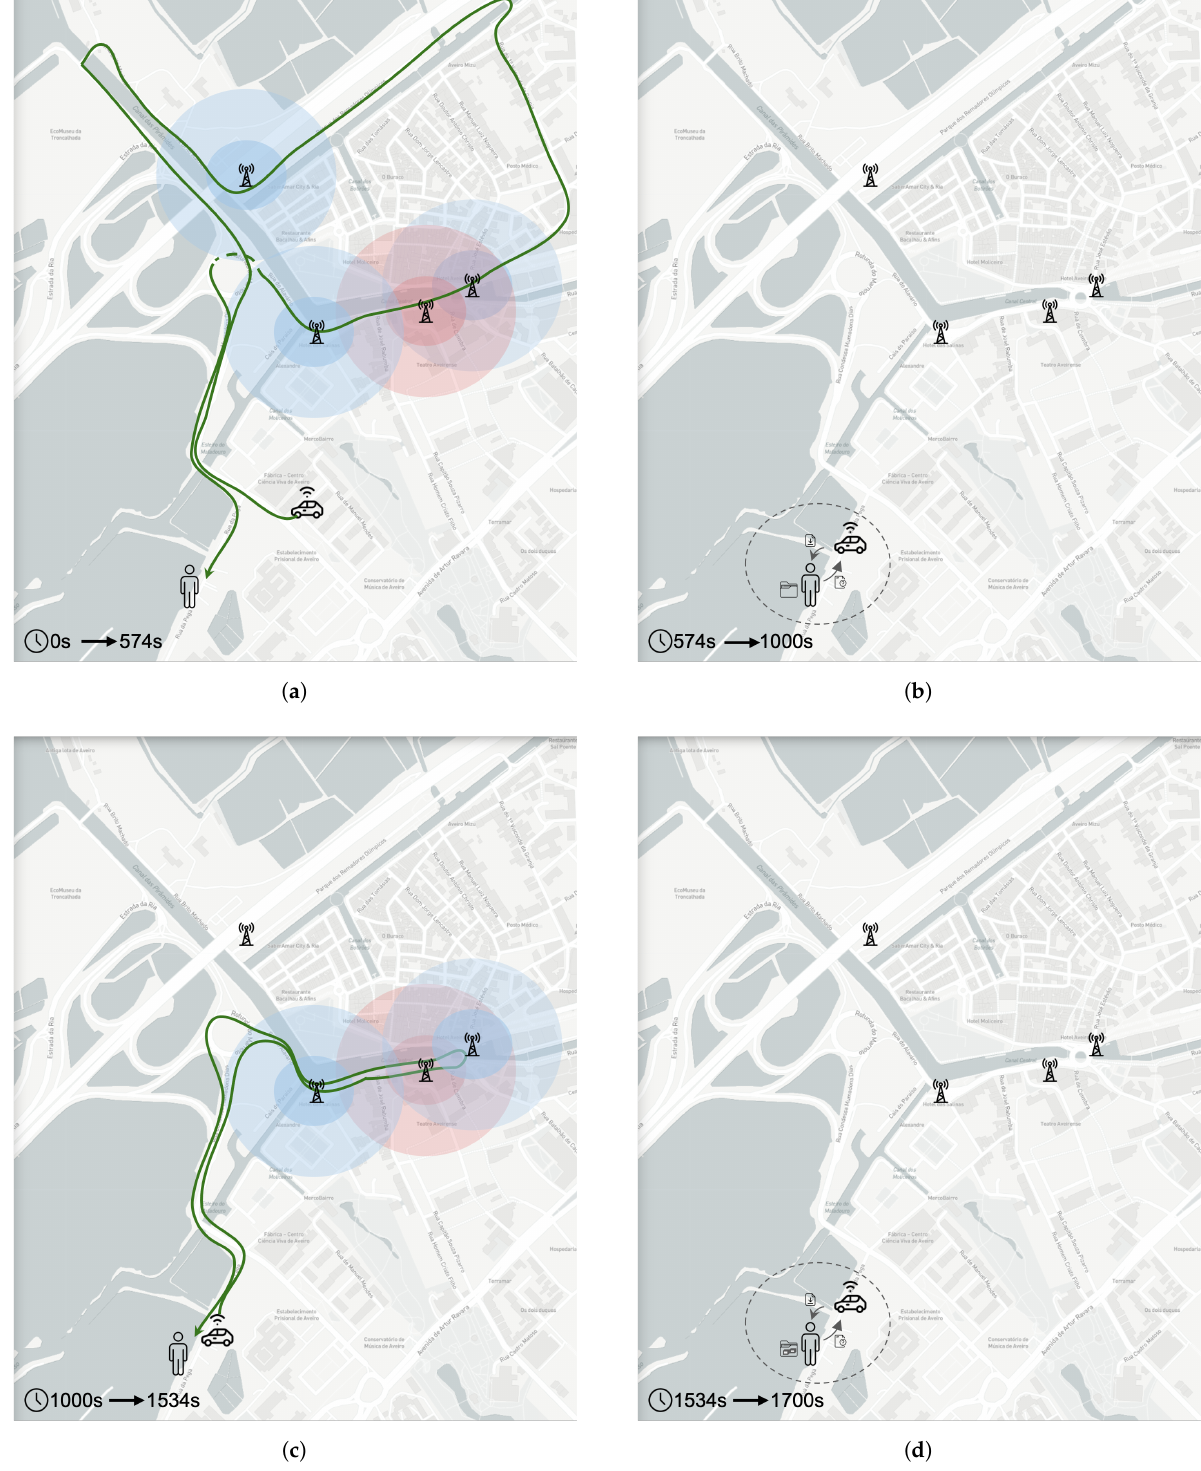
Figure 7. Route performed by the mobile node in the first experiment. ( a ) Between t = 0 s and t = 574 s the vehicle connects with four RSUs. ( b ) Between t = 574 s and t = 1000 s both vehicle and pedestrian are in communication range. ( c ) Between t = 1000 s and t = 1534 s the vehicle travels around the city, connecting with three RSUs. ( d ) Finally, the vehicle ends its journey next to the